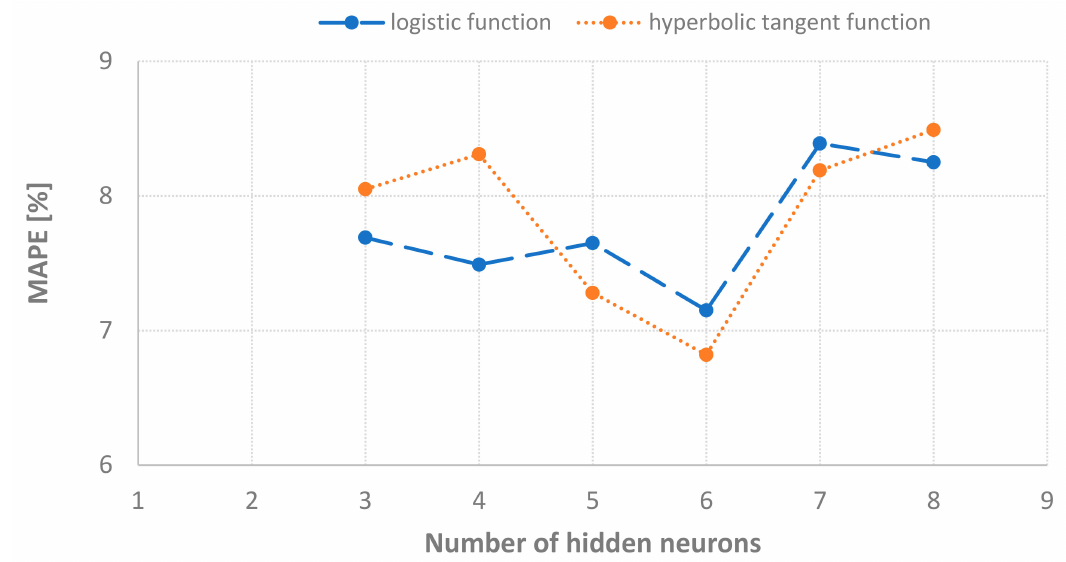
Figure 1. Selection of neural network parameters for prediction of the average methane seam pressure, based on the mean prediction error of the neural